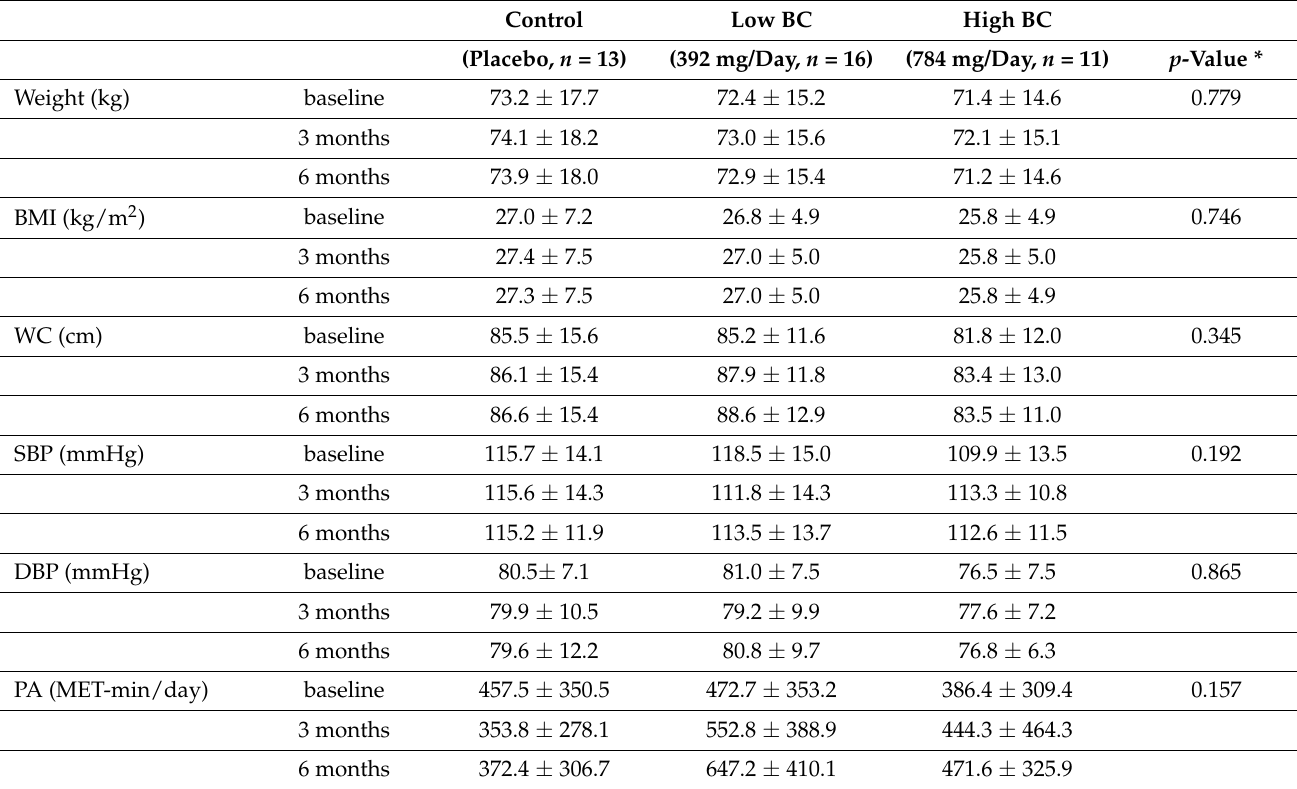
Table 3. Anthropometric characteristics, blood pressure and physical activity (mean, SD) of study participants at baseline, three months, and six